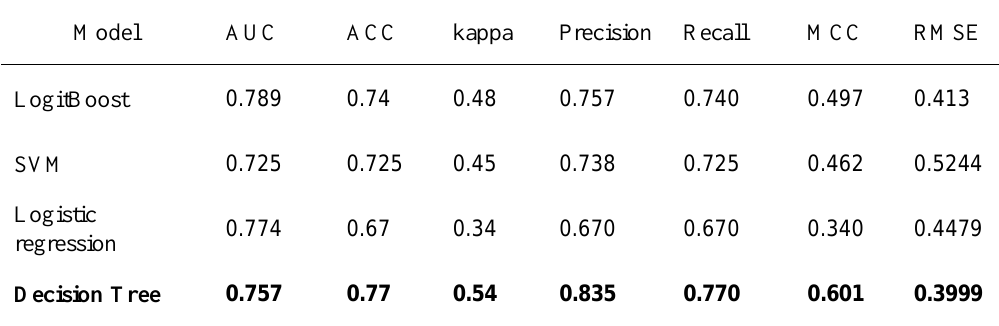
Table 3. Classification performance for GLCM